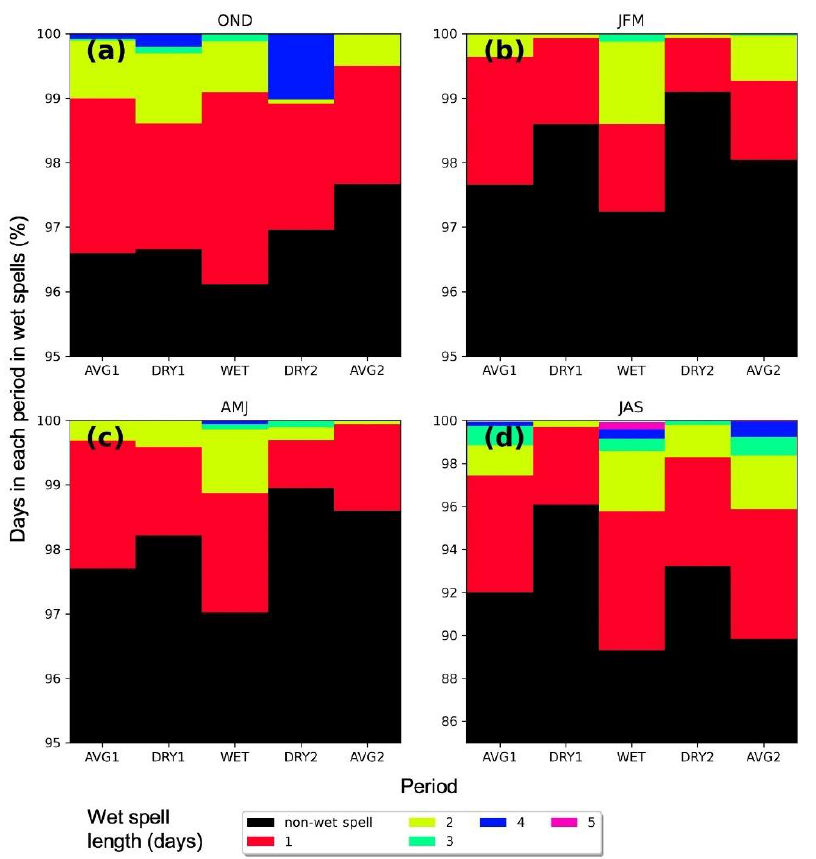
Figure 9. Percentage of days in each period in wet periods of varying durations (days) as an average of 16 locations for each season. ( a ) OND, ( b ) JFM, ( c ) AMJ, and ( d ) JAS. Black bars represent the percentage of days not in a “wet period” of more than one day.